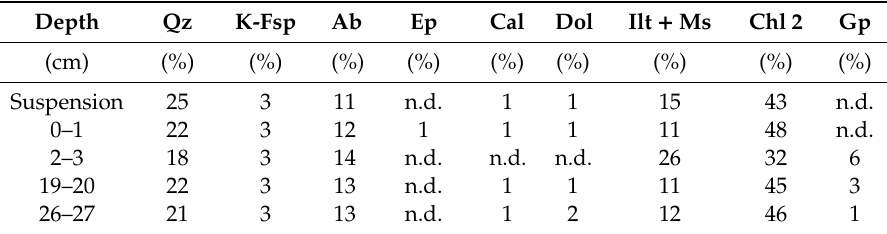
Table 2. Mineral composition of near-bottom suspension and bottom sediments of the AMK-5424 core according to XRD analysis.